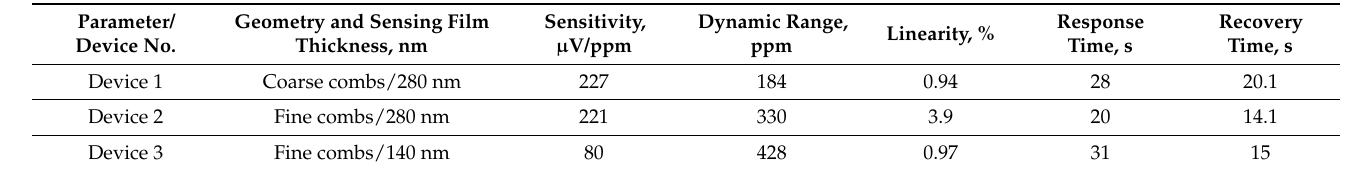
Table 1. Main ethanol detection parameters of SAW devices with different IDT patterns and using carbyne-enriched coating as a sensing